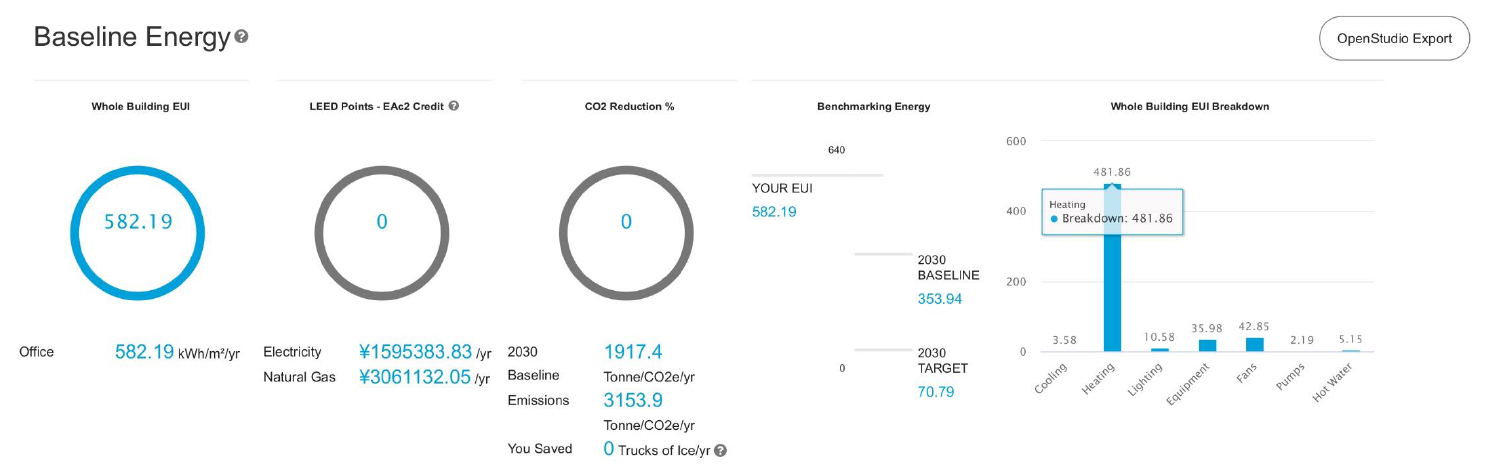
Figure A24. Zone 5-A Shenyang, Liaoning (post-COVID-19 84% scenario).